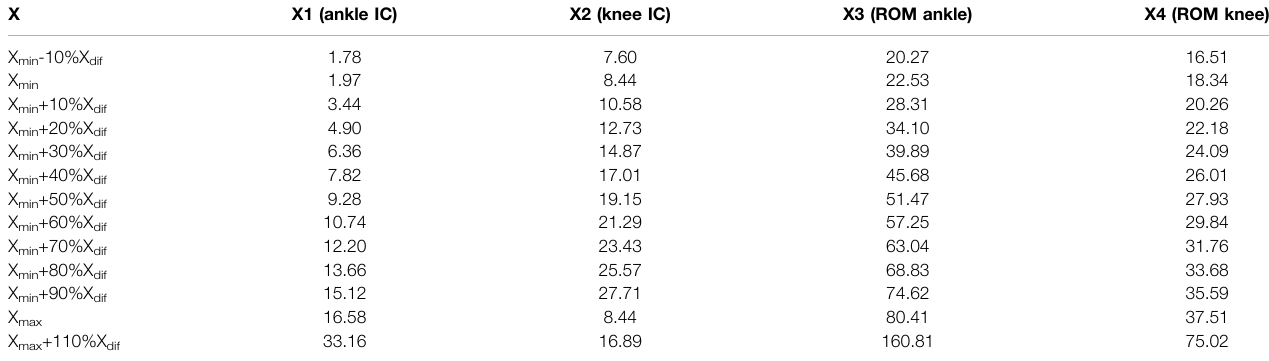
TABLE 2 | The predictors of each predictive variable.